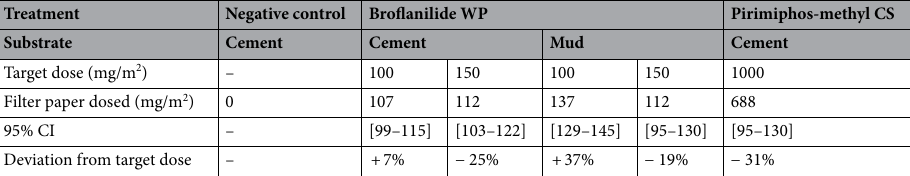
Table 4. Results for chemical analysis of filter papers from experimental huts treated with broflanilide WP and pirimiphos-methyl